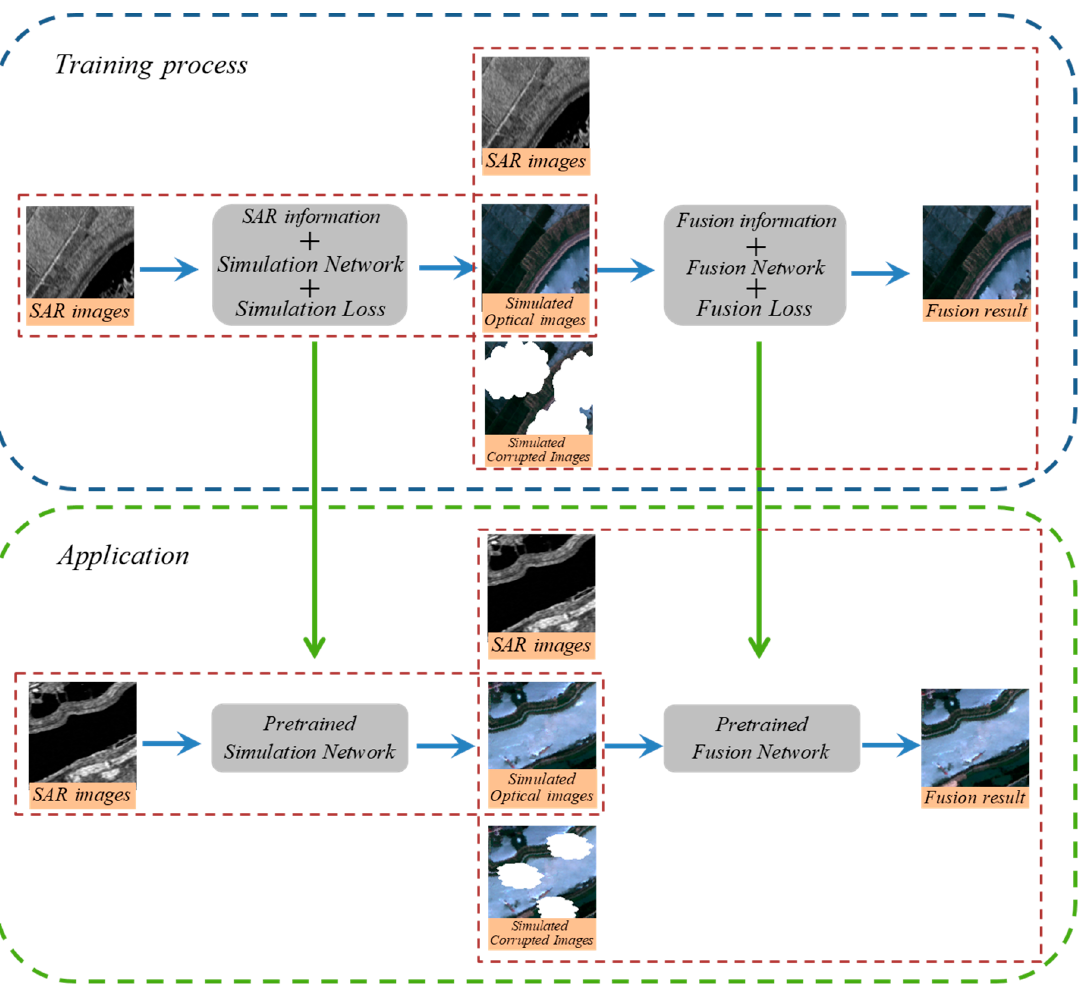
Figure 1. Flowchart of the proposed model for cloud removal.